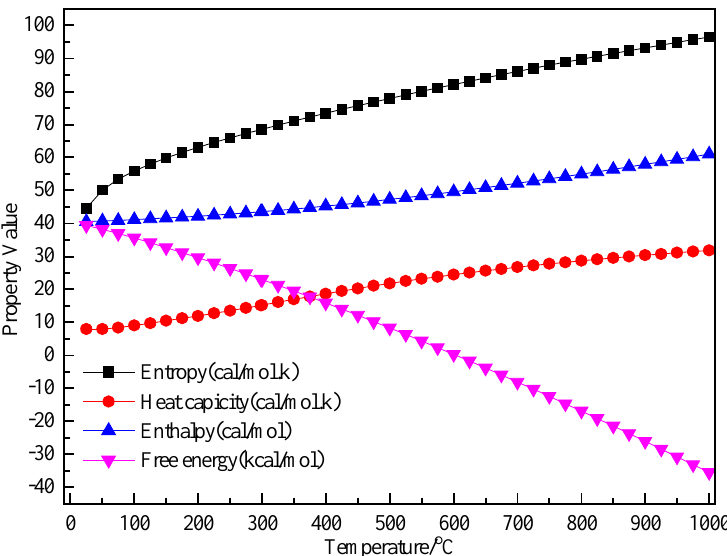
Figure 2. Molecular model of C 2 H 5 Br molecule. ( a ) Initial model; ( b ) Optimized model. The unit of the angle in the image is ( ◦ ), and the unit of the bond length is angstrom (Å).